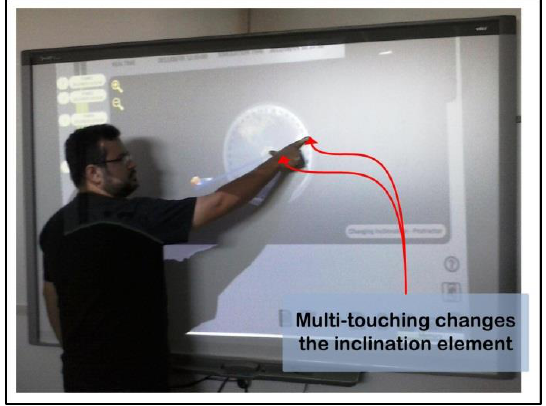
Fig. 22. Multi-Touch interaction to change a satellite orbit